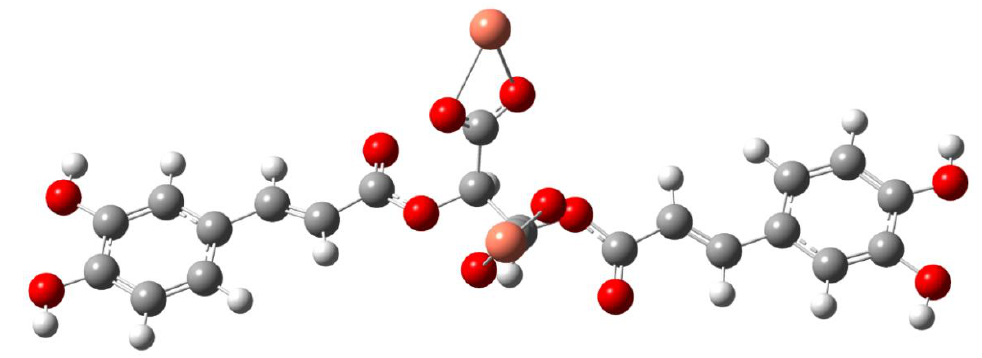
Figure 3. The propoedl structures of copper and cobalt cichoriate structures.